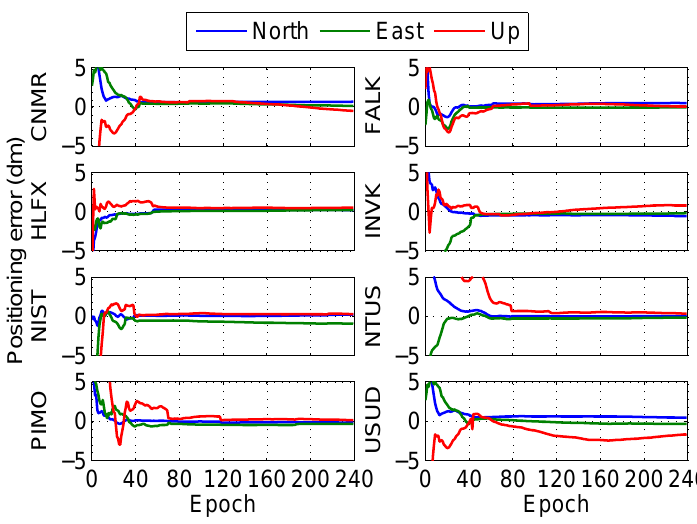
Figure 9. Positioning error of fixed solution at different stations in the post-processing PPP.